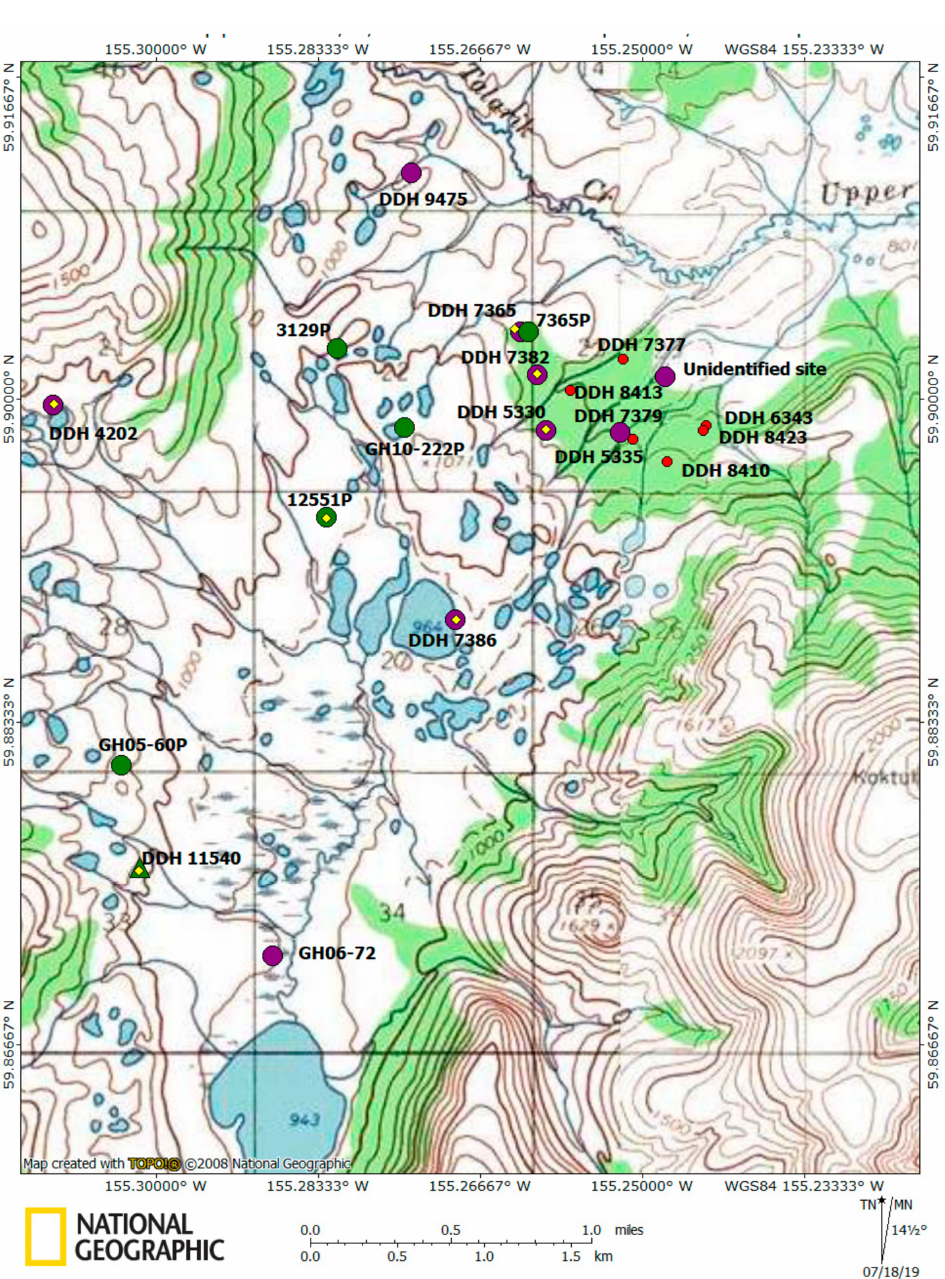
Figure 3. Location of select sites. Sites with laboratory analysis or for which visual inspection suggested current or future environmental issues. Purple circles—openly flowing or potential artesian sites. Red circles—modified drill stems possibly to repress artesian flow. Green triangle—DDH (diamond drill-holes) 11540, where drill sump material appears to be contaminating a wetland spring. Green circles—sites for which laboratory analysis did not show strong evidence of contamination. Locations with elevated Cu concentrations or trends are noted by a yellow diamond within the circle. Map created using National Geographic TOPO!